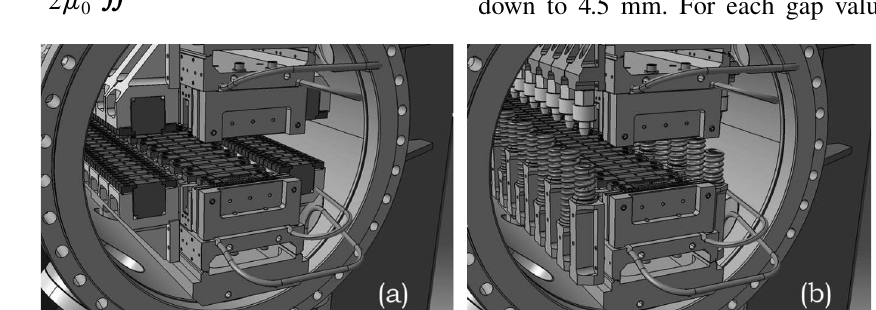
FIG. 5. Magnetic counterforce system (a) and spring counterforce system